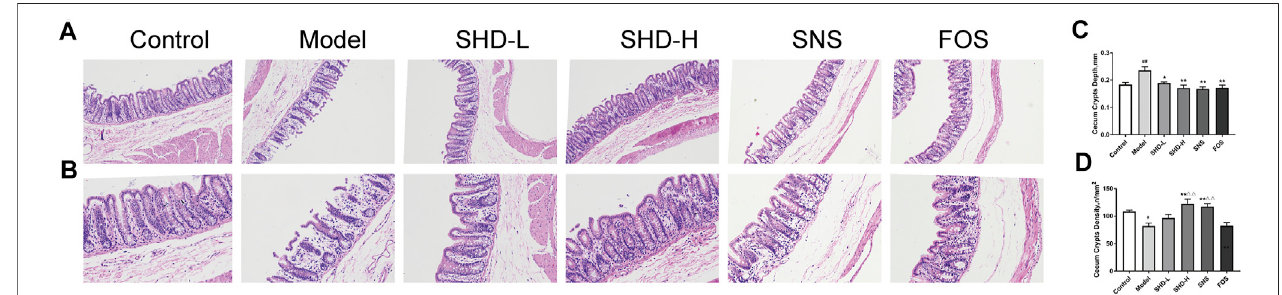
FIGURE 4 | SHD alleviates cecum mucosal histopathology and improves cecum mucosal injury in CUS model rats. (A) Sections stained with H&E staining to assess the cecum mucosal injury ( × 100). Scale bar (cid:2) 50 μ m. (B) Sections stained with H&E to assess the cecum mucosal injury ( × 200). Scale bar (cid:2) 50 μ m.